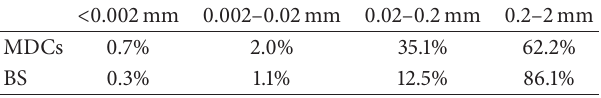
Table 1: Soil particle size of the top layer (0–2cm) in bare sand (BS) and moss-dominated crusts